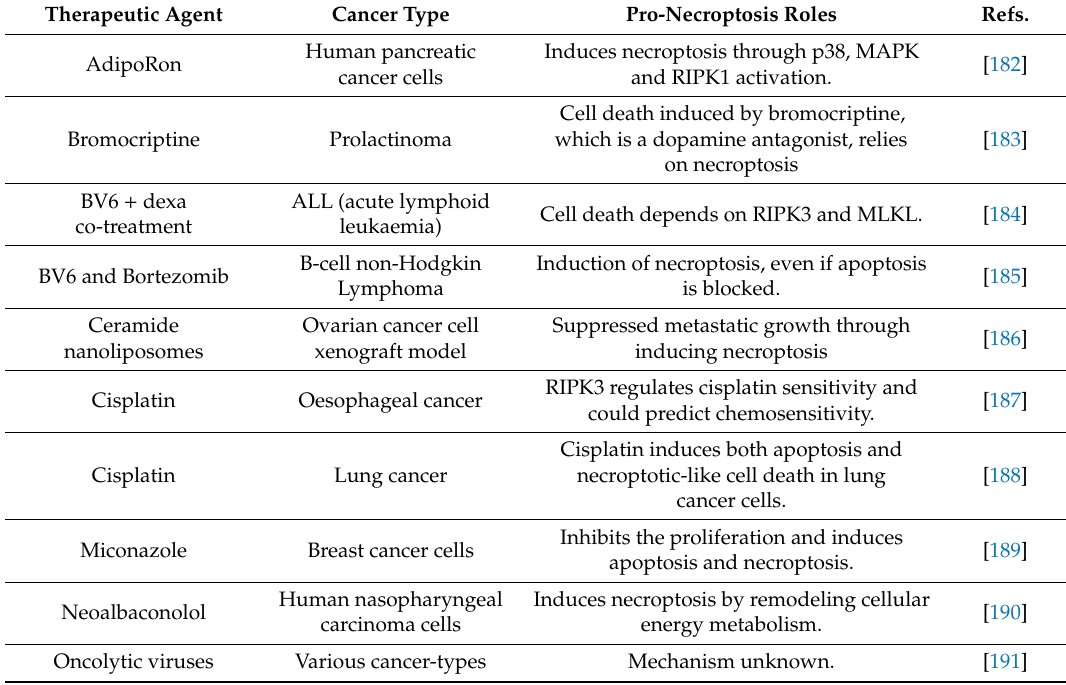
Table 1. Chemical or biological therapeutic agents capable of inducing necroptosis in